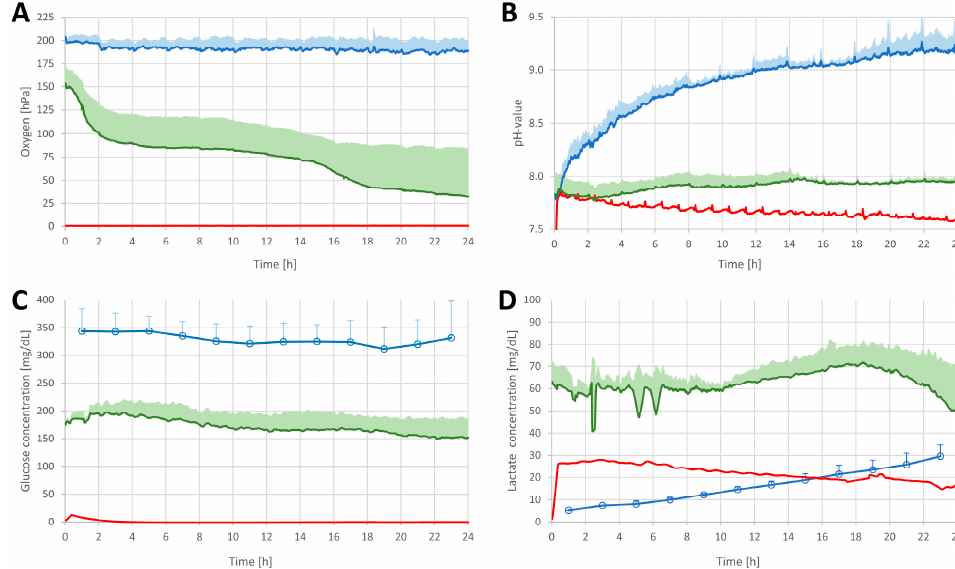
Figure 4. Tissue parameters measured online in FTSE (green line) and skin explants (red line) and culture medium (blue line for oxygen ( A ) and pH ( B )) and offline in culture medium (blue dots for glucose ( C ) and lactate ( D )). Data represent the average of n = 3 (for readability only upward SD is shown except for skin explants where only one sample was measured).